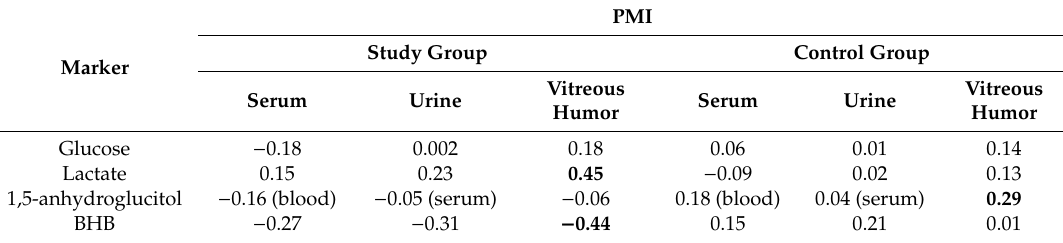
Table 9. Correlation between PMI (time from death to collection of biological material) and the concentrations of the analyzed markers. Significant correlations are in bold.